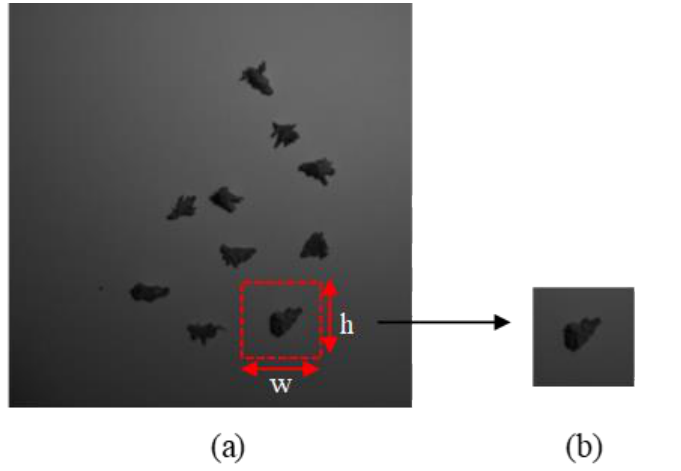
Figure 2. Cropping method, h and w represent height and width of the image, respectively ( a ) input image, ( b ) cropped image.